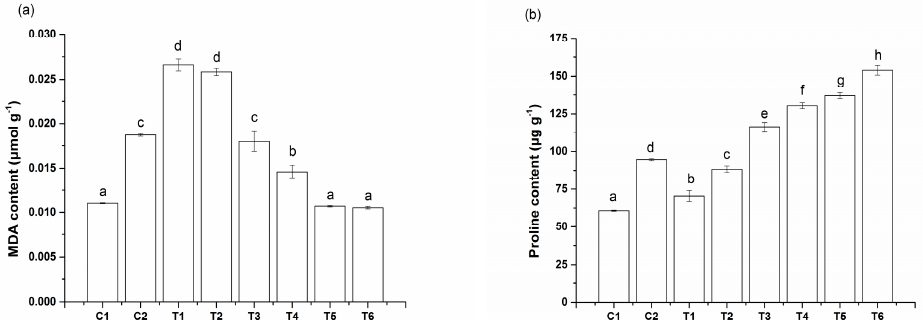
Figure 2. E ff ects of IAA on malondialdehyde (MDA) ( a ) and proline ( b ) contents of spinach seedlings under Cu stress. Values and error bars indicate means ± standard deviation ( n = 3). Di ff erent letters indicate a significant di ff erence between treatments at p < 0.05 according to Duncan’s multiple-comparisons test.